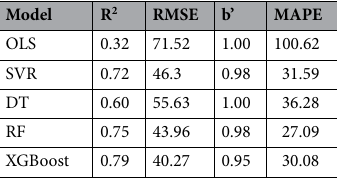
Table 2. Performance analysis of the different regression models on the collected dataset of carbon-based supercapacitors.